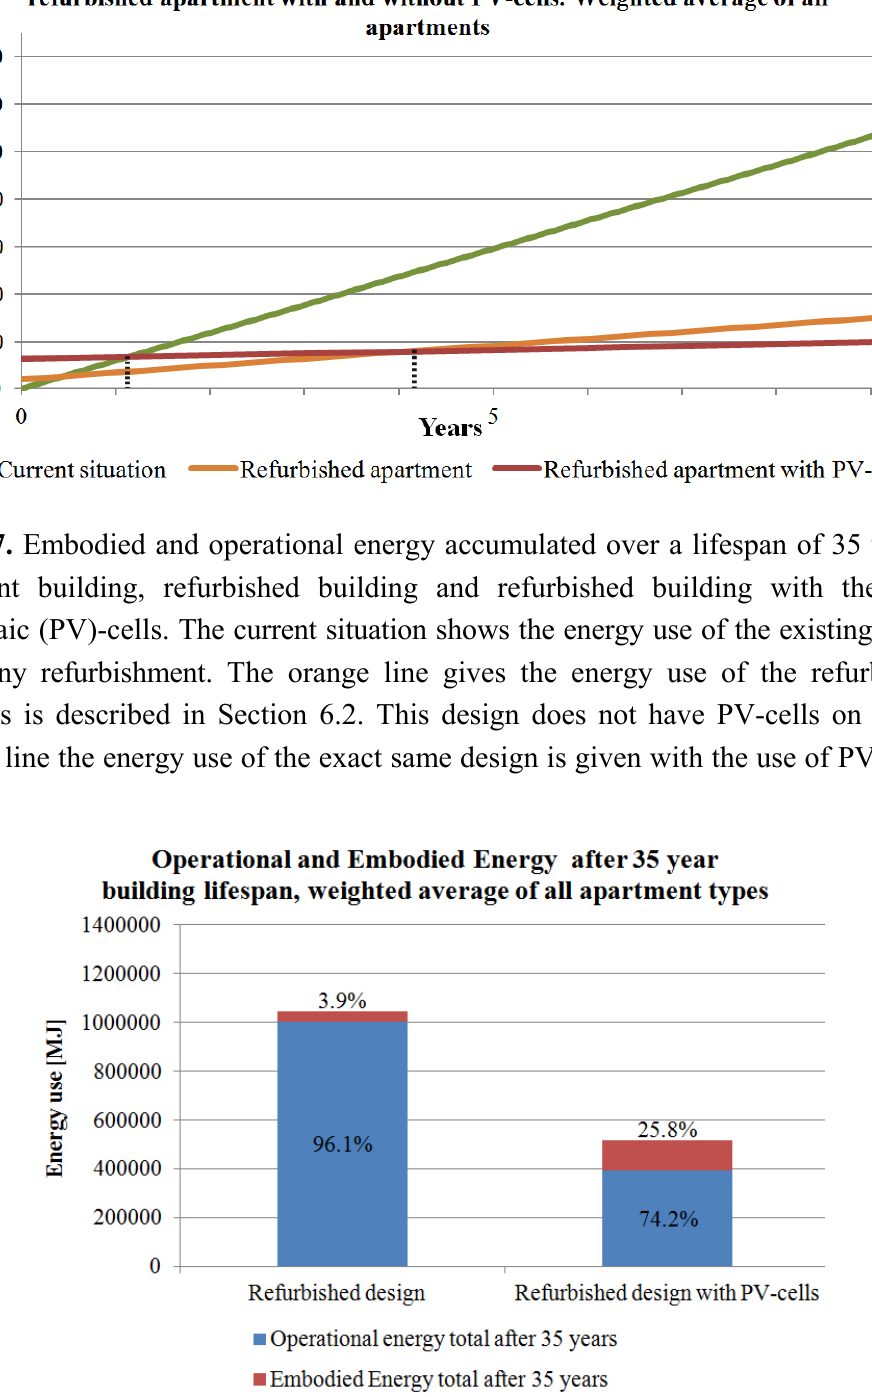
Figure 18. Operational and embodied energy use total over a lifespan of 35 years for the refurbished design and the same design with PV